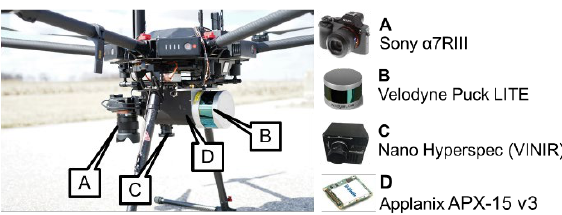
Figure 1. The UAV-based mobile mapping system and onboard sensors used in this study.